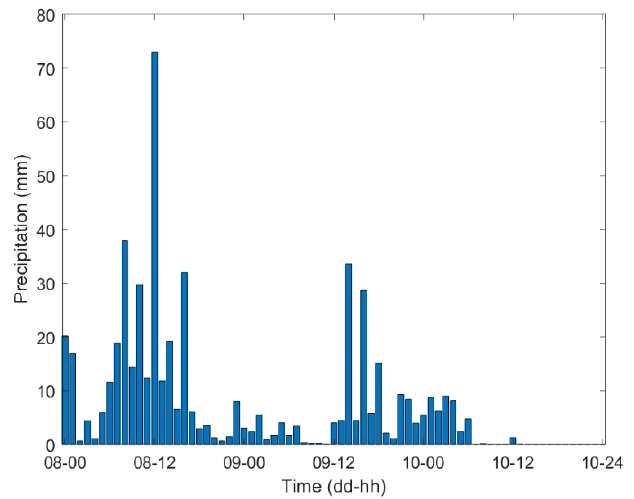
Figure 3. Hourly cumulative rainfall data in the 3-day period 8–10 October 2021 from the King’s Park station. Park station.